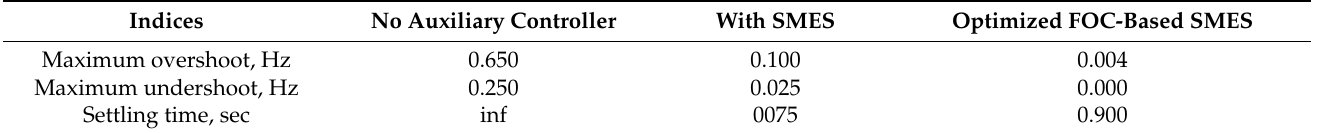
Figure 14. Frequency response for both areas under multiple load profile variations. Table 3. Performance indices improvement with FOC-based SMES.